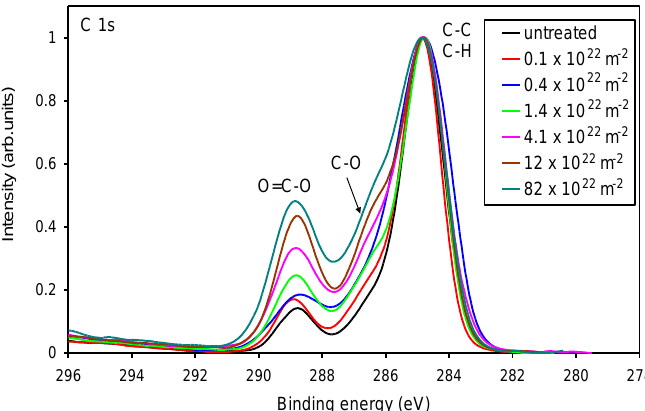
Figure 5. Comparison of high-resolution XPS carbon C 1s spectra of the acryl-coated PP polymer. The parameter is the O-atom fluence.